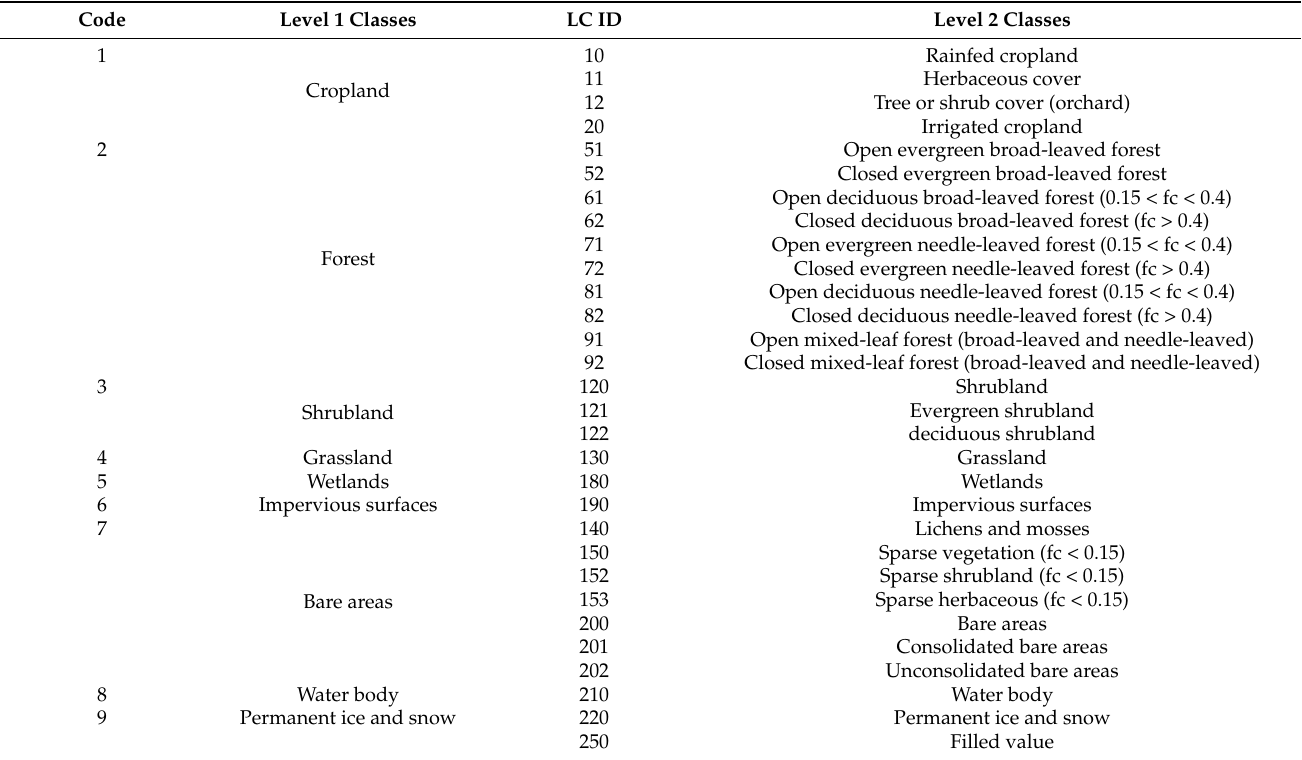
Table 1. LULC classification system of GLC_FCS30.